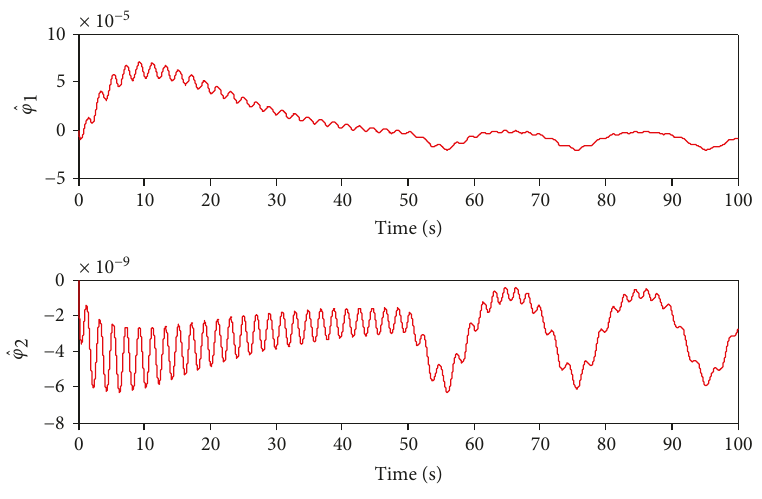
Figure 7: Estimations of φ